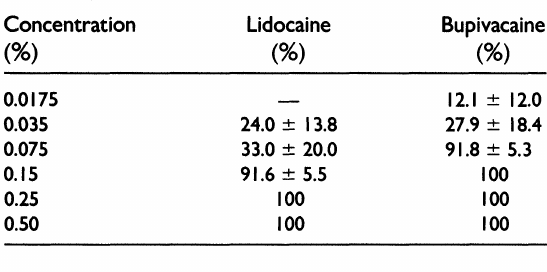
TABLE I. Percent of germ tube formation inhibition at serial concentrations of local anesthetic Concentration